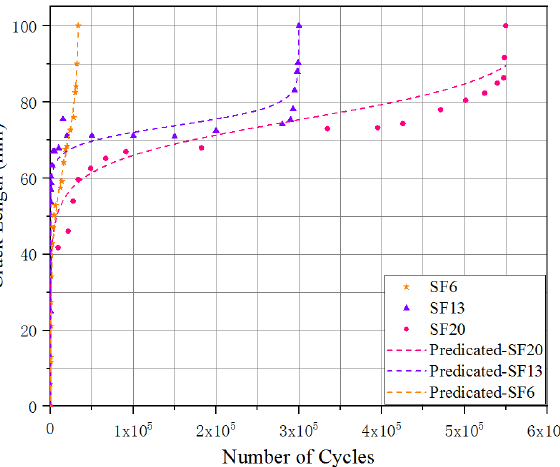
Figure 7. Relationship between fatigue crack length and number of cycles. Table 4. Summary of the experimental calibration constants for Equation (1). Table 4. Summary of the experimental calibration constants for Equation